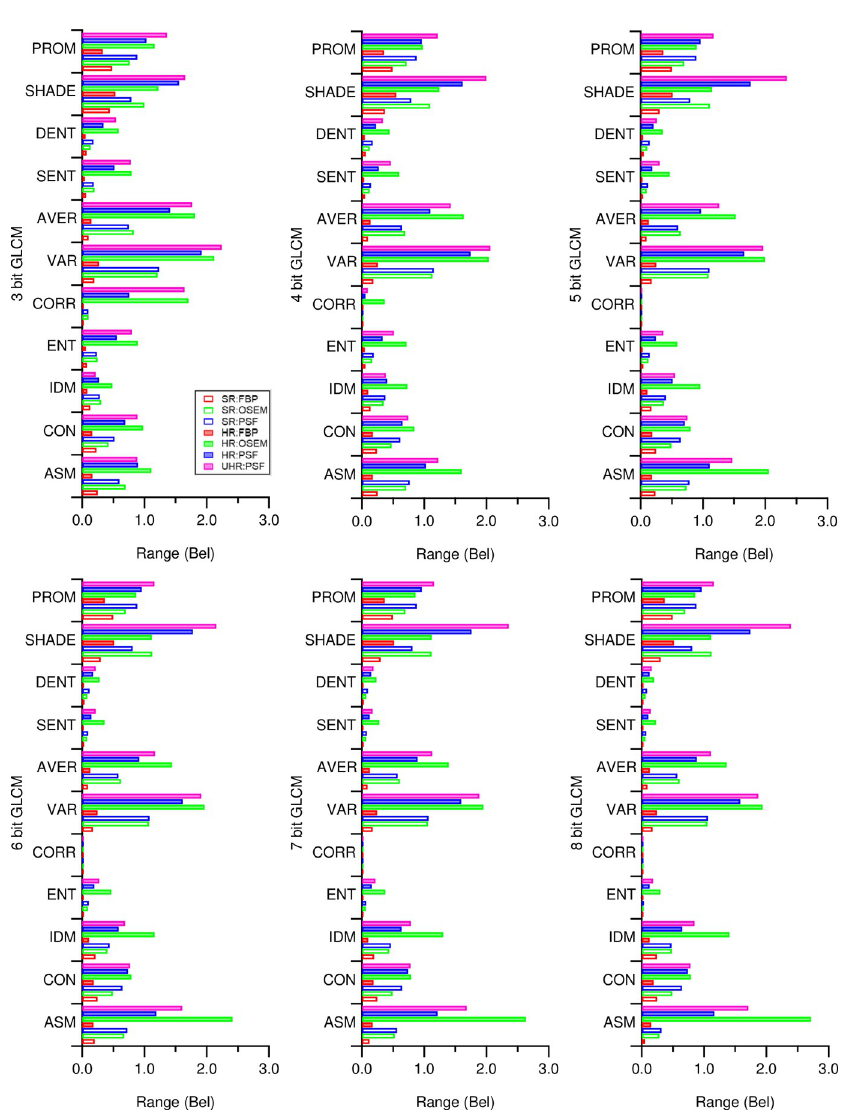
Fig 6. Magnitudes of textural feature variability. Shown is the absolute range between the lowest and highest values in units of Bel found in the texture features across all examined exposures calculated 8-bit GLCMs (a), from 7-bit GLCMs (b), from 6-bit GLCMs and were also found in first order statistics (d). Lilliefor’s p varied up to 12 orders of magnitude and is therefore not shown to scale. Color Legend in (a) applies to all. reconstruction methods, with FBP producing the most robust Haralick features and non-lin- ear iterative image reconstructions (PSF and OSEM) producing the largest variability. Conse- quently, image resolution correlated inversely with the exposure levels needed for obtaining stable Haralick feature values. Most feature-reconstruction combinations showed monotonic curves with stable plateaus (Fig 5) when plotted against exposure. Greyscale mapping pro- duced GLCMs with congruent positions within the matrix, making full use of the available matrix size (Fig 4). On the other hand, full-range GLCMs drifted across the matrix according to the grey scale range occurring in the image (S2 Fig). This additional degree of freedom could explain the non-monotonic curves and the larger variability of full range GLCMs (S4 and S5 Figs and S2 Text).